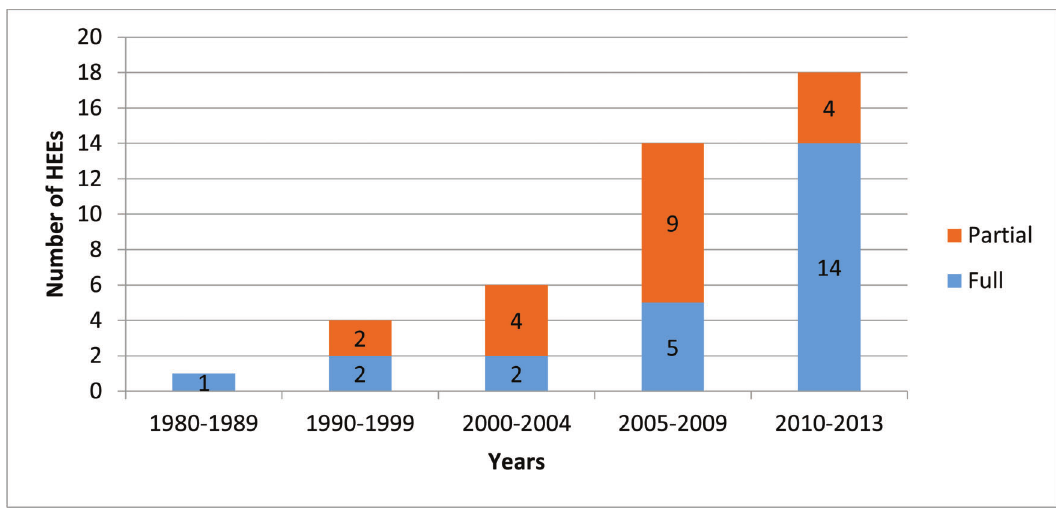
Figure 2 - Growth of HEEs related to diagnostic tests (n=43) in Brazil,